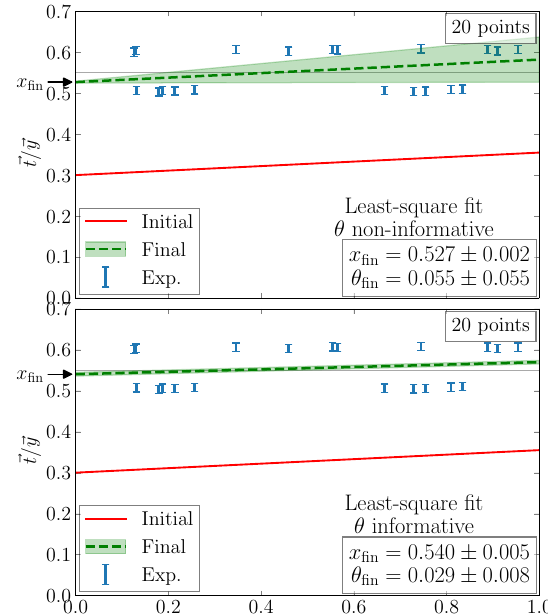
Figure 2. Analysis of the 20 points data set with the toy model data by Bayesian inference with and without fit of θ